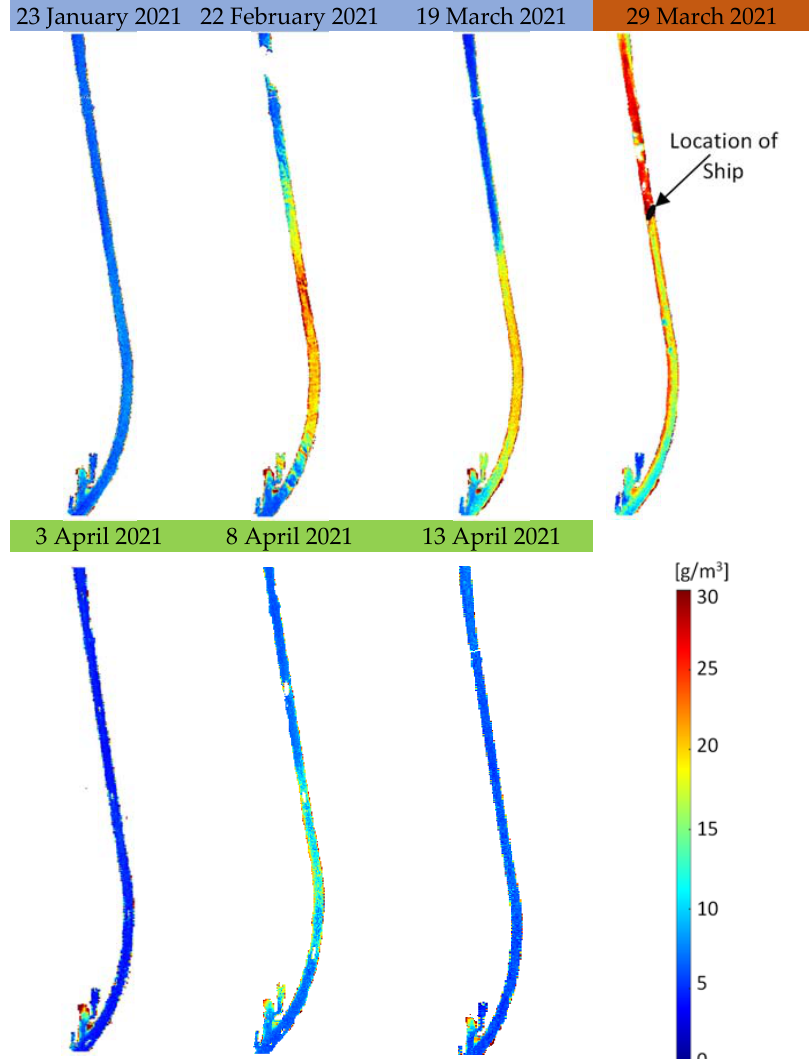
Figure 2. Multitemporal TSM maps of the Suez Canal derived from Sentinel-2 imagery before ( blue ), during ( red ), and after ( green ) the canal blockage event.